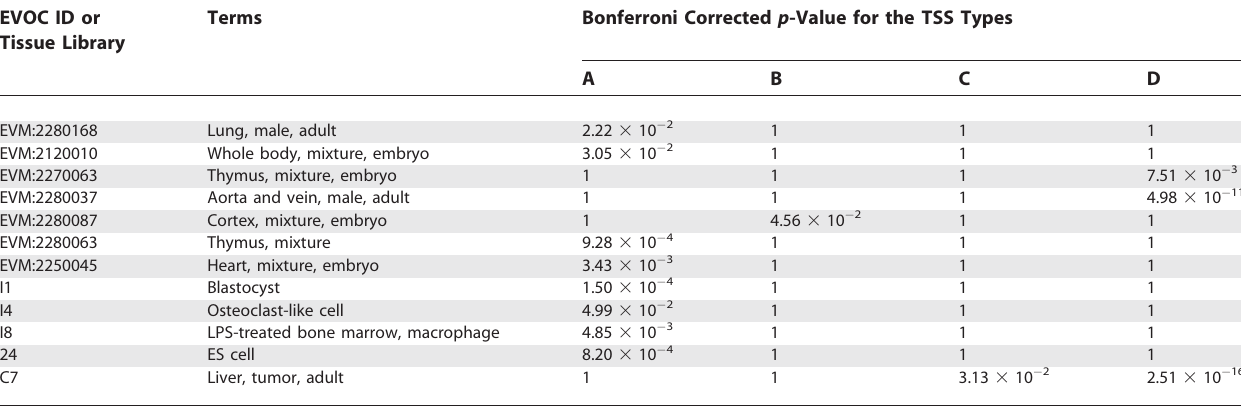
Table 6. Enrichment of TSS Types in Selected eVOC Categories and Tissue Libraries in Mouse EVOC ID or Tissue Library